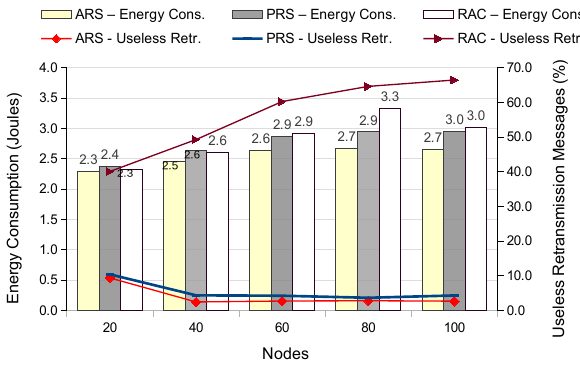
Figure 15. Correlation between energy consumption and useless retransmission